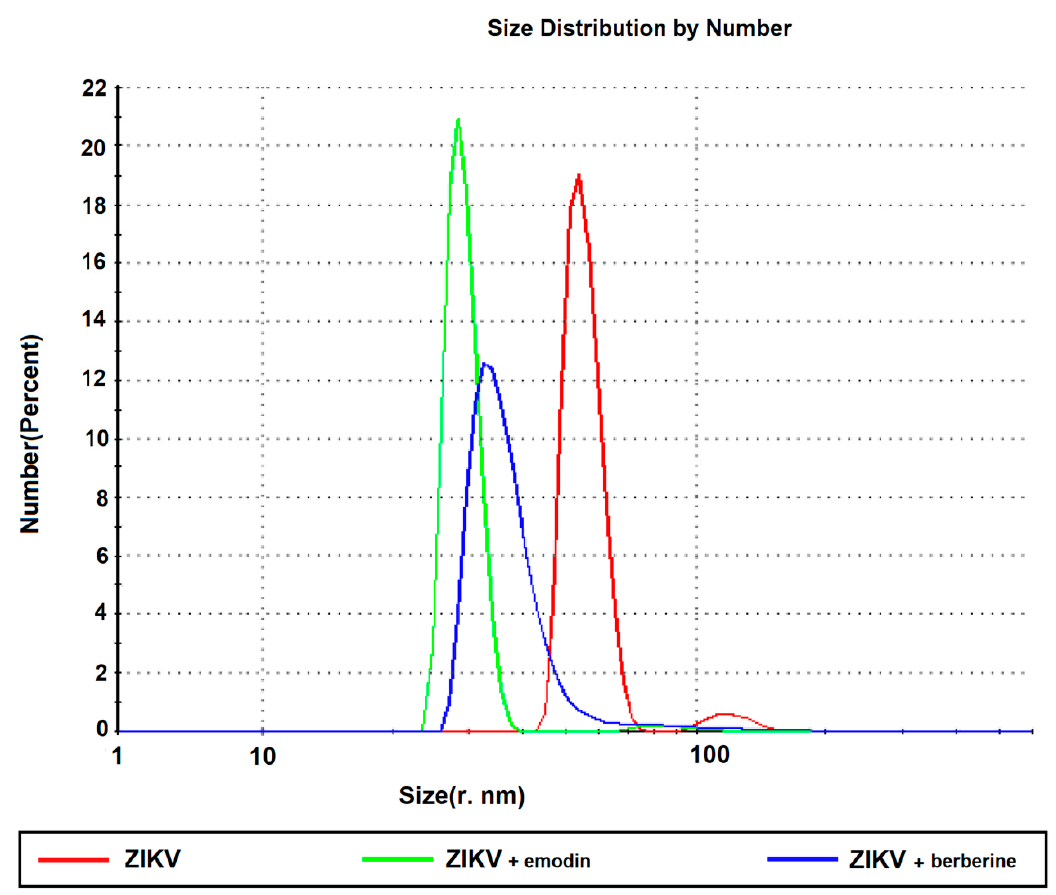
Figure 4. Dynamic light scattering analyses of virus particles after incubation at 37 °C in absence of drug (red line), in the presence of 40 µM emodin (blue line) and 160 µM berberine (green line), indicating the estimated hydrodynamic radius.